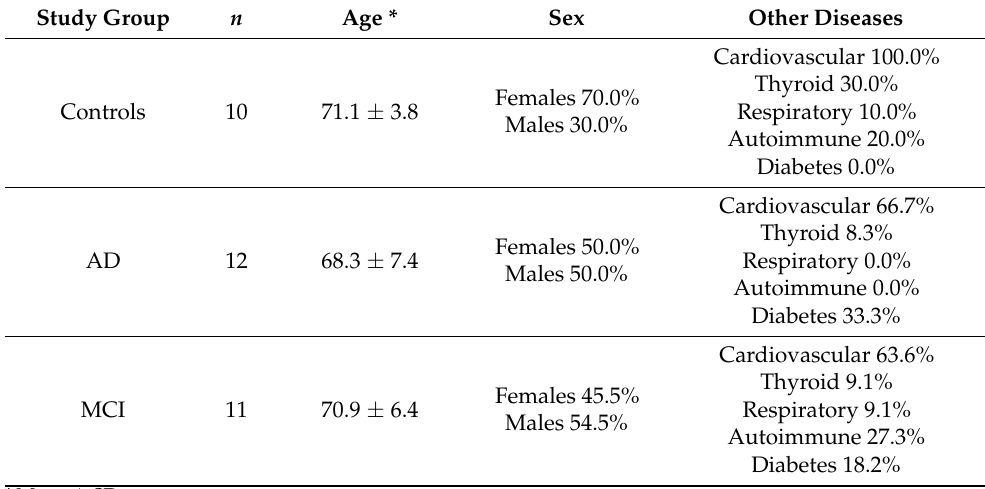
Table A1. Demographic information of the biopsy donors of olfactory mucosa (OM) cell lines used for RNA sequencing.